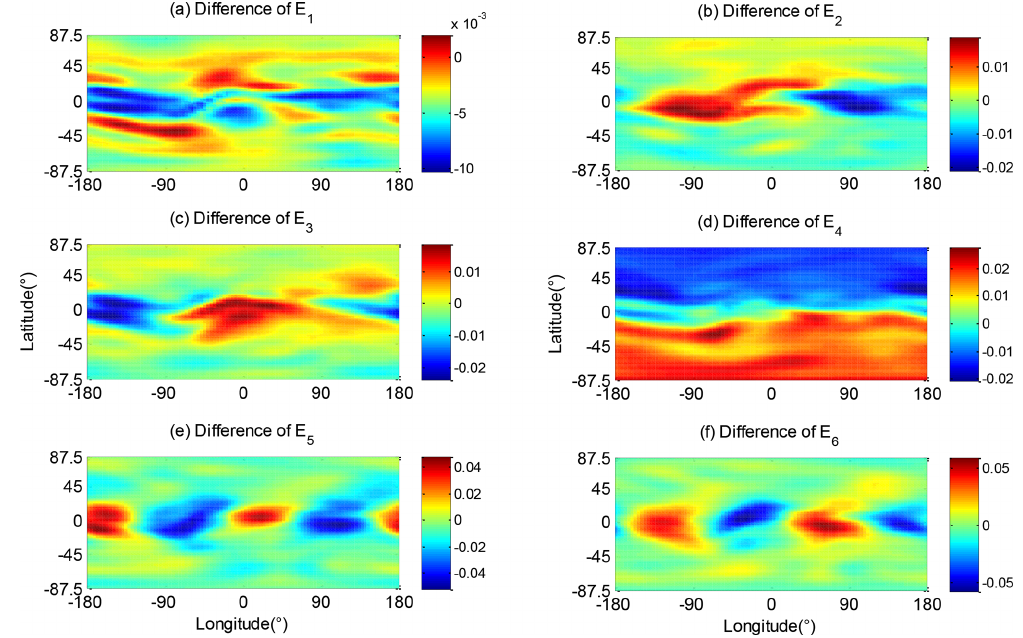
Figure 7. Differences of the first six orders of the base functions of GIM-TEC and IRI-TEC.